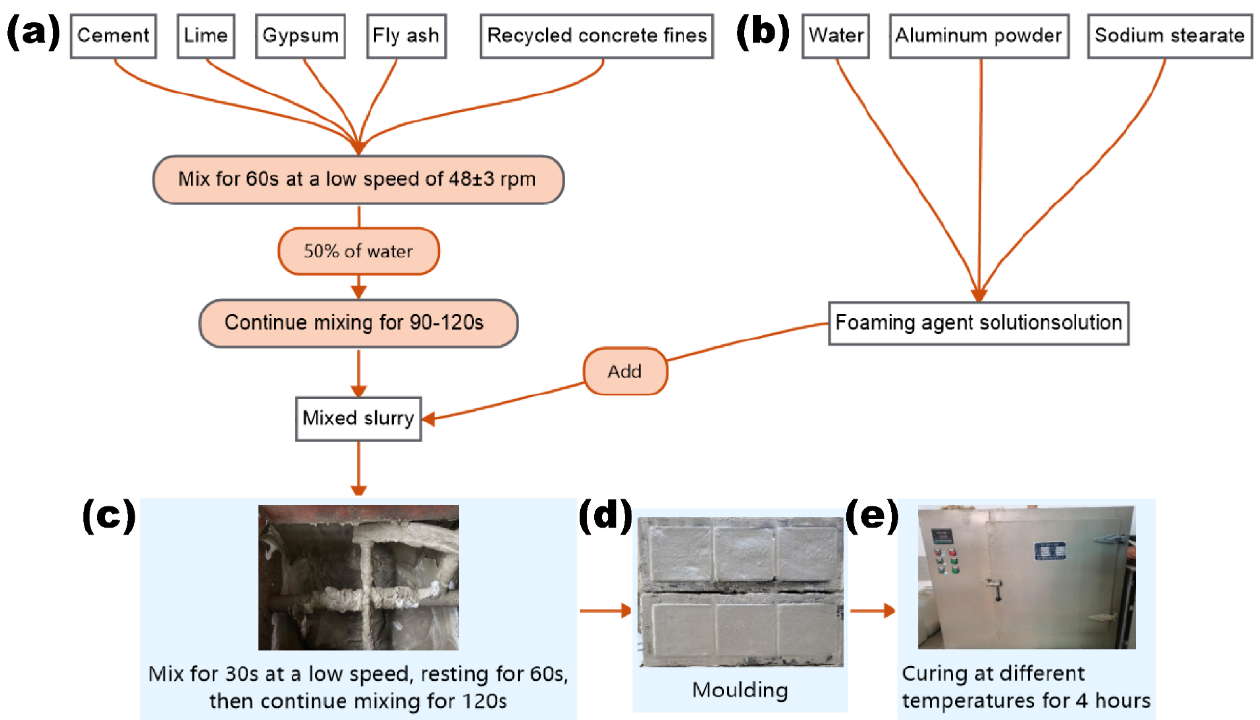
Figure 2. The preparation process of NAAC. For the measurement of thermal conductivity, the slurry in a fresh state was poured into pre-prepared 100 mm × 100 mm × 100 mm molds brushed with lubricants and compacted with a metal rod. The molds with concrete were then placed into an oven with a relative humidity of 40 ± 5% for 4 h, and the curing temperatures were controlled at T1 (30 ◦ C), T2 (35 ◦ C), T3 (40 ◦ C), T4 (45 ◦ C) and T5 (50 ◦ C), respectively. After the NAAC formed and expanded, the increased volume was removed by using scraper. Next, the specimens were covered with plastic sheeting and kept indoors at a temperature of 22 ± 2 ◦ C for 24 h. Finally, the specimens were demolded and naturally cured to the specified age for performance testing. To increase the reliability of test results, three samples of each mixture were